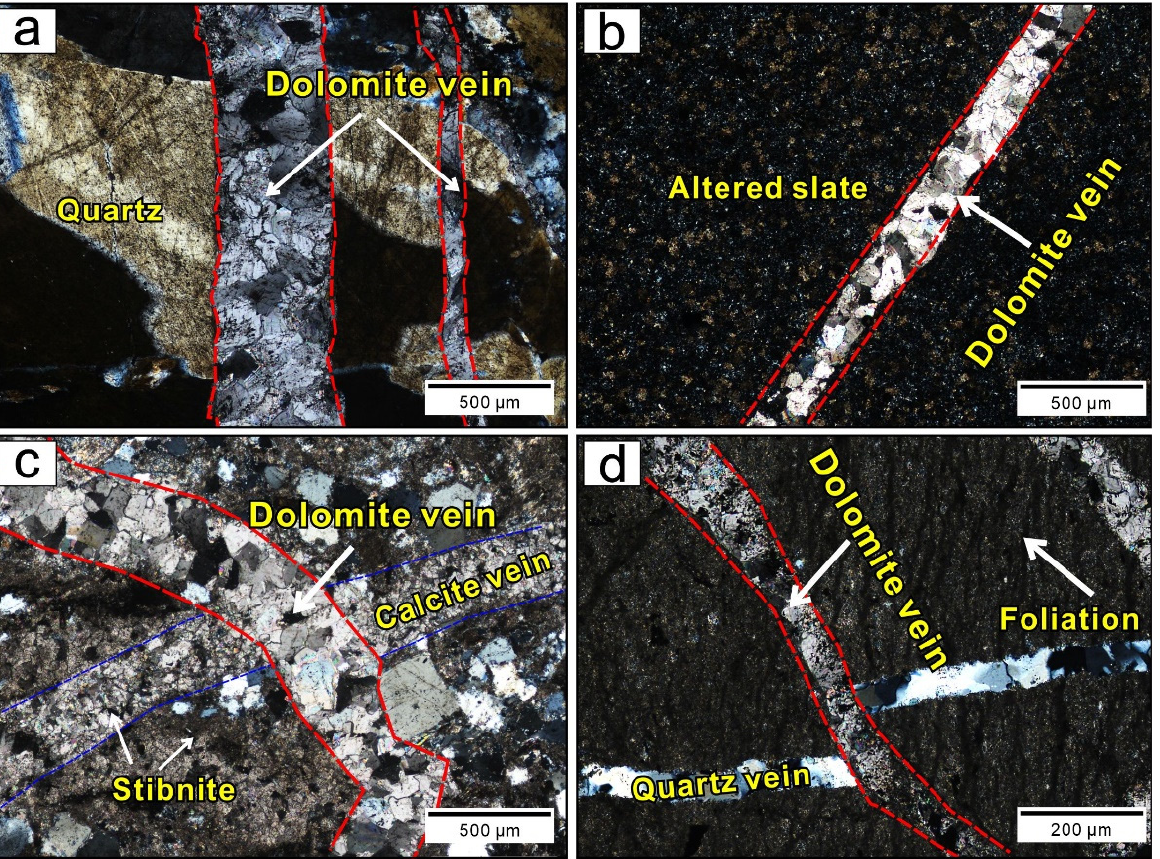
Figure 4. Photomicrograph in samples showing ( a , b , d ) the dolomite veins cross cut the veinlets correlated with mineralization and wall rock Triassic slate, ( c ) dolomite vein crosscut calcite vein related to ore.